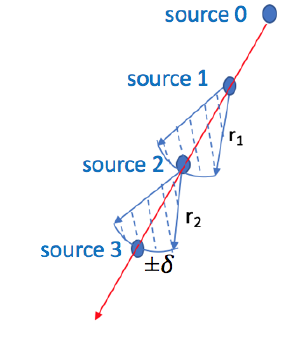
Table 1: NIKA2 astrometry and photometry of unambiguously detected sources at 1.15